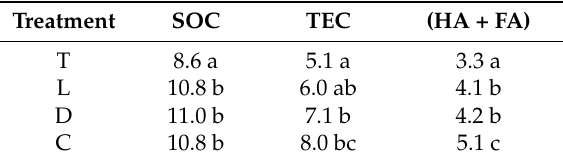
Table 1. Concentration of SOC, TEC and (HA + FA) in soil (g kg − 1